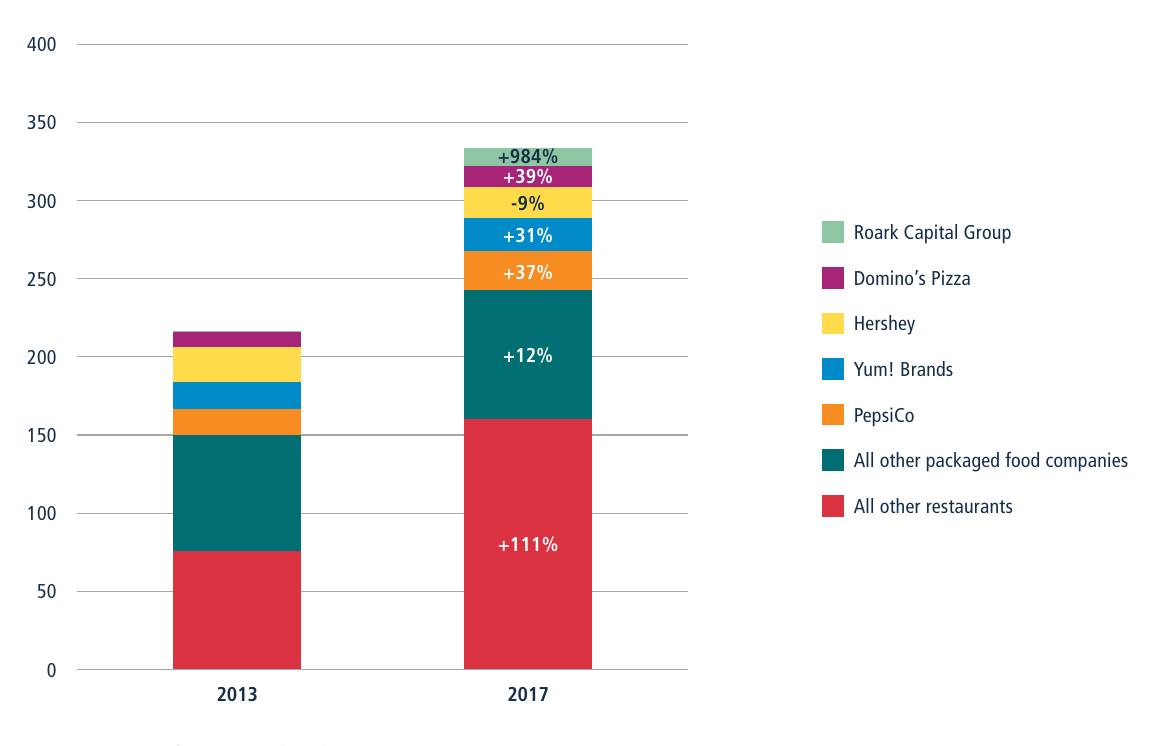
FIGURE 7. CHANGE IN TOTAL FOOD-RELATED AD SPENDING ON BLACK-TARGETED TV